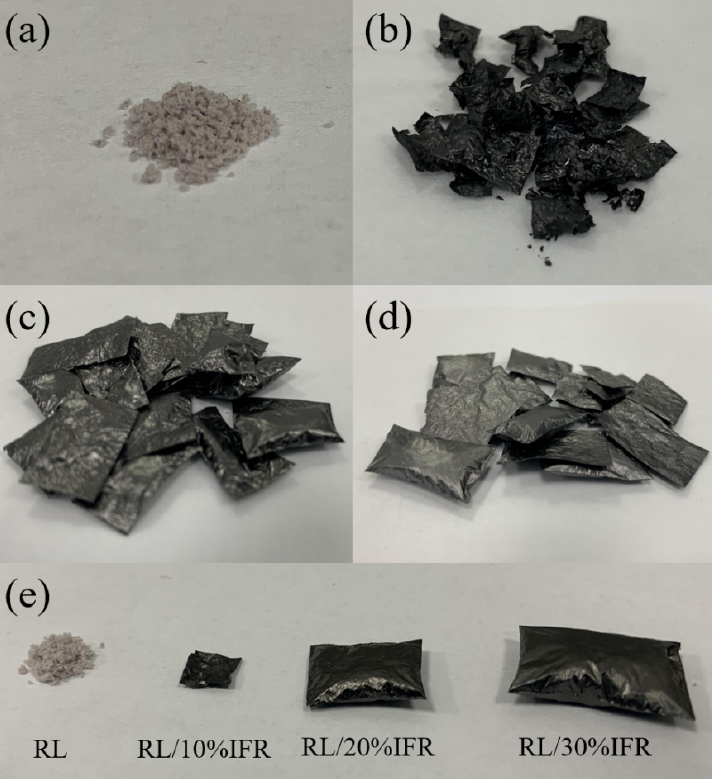
Figure 5. Images of lacquer films with different FR contents after 1.5 h combustion in a muffle furnace at 500 ◦ C ( a ) RL, ( b ) RL/10%IFR, ( c ) RL/20%IFR, ( d ) RL/30%IFR, and ( e ) contrast Table 1. Char formation rates of lacquer films with different FR contents.